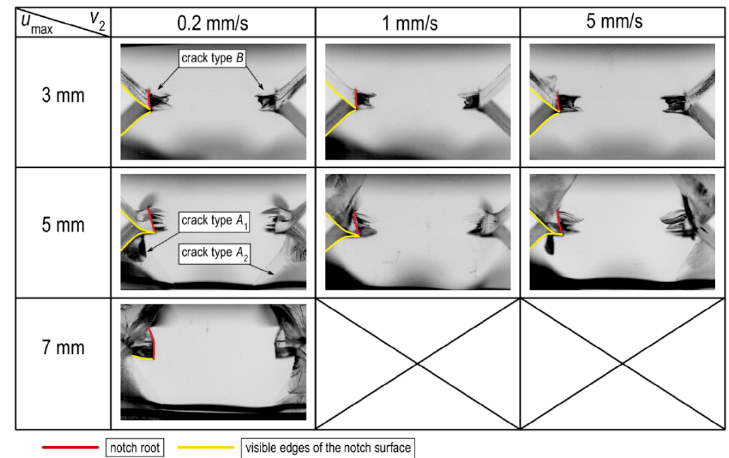
Figure A2. Deformation in the sharp V-notched specimens ( t 2 ) after the unloading for u max = 3, 5, and 7 mm and (cid:2013)̇ (cid:2870) 8 × 10 −3 , 4 × 10 −2 , and 2 × 10 −1 s −1.